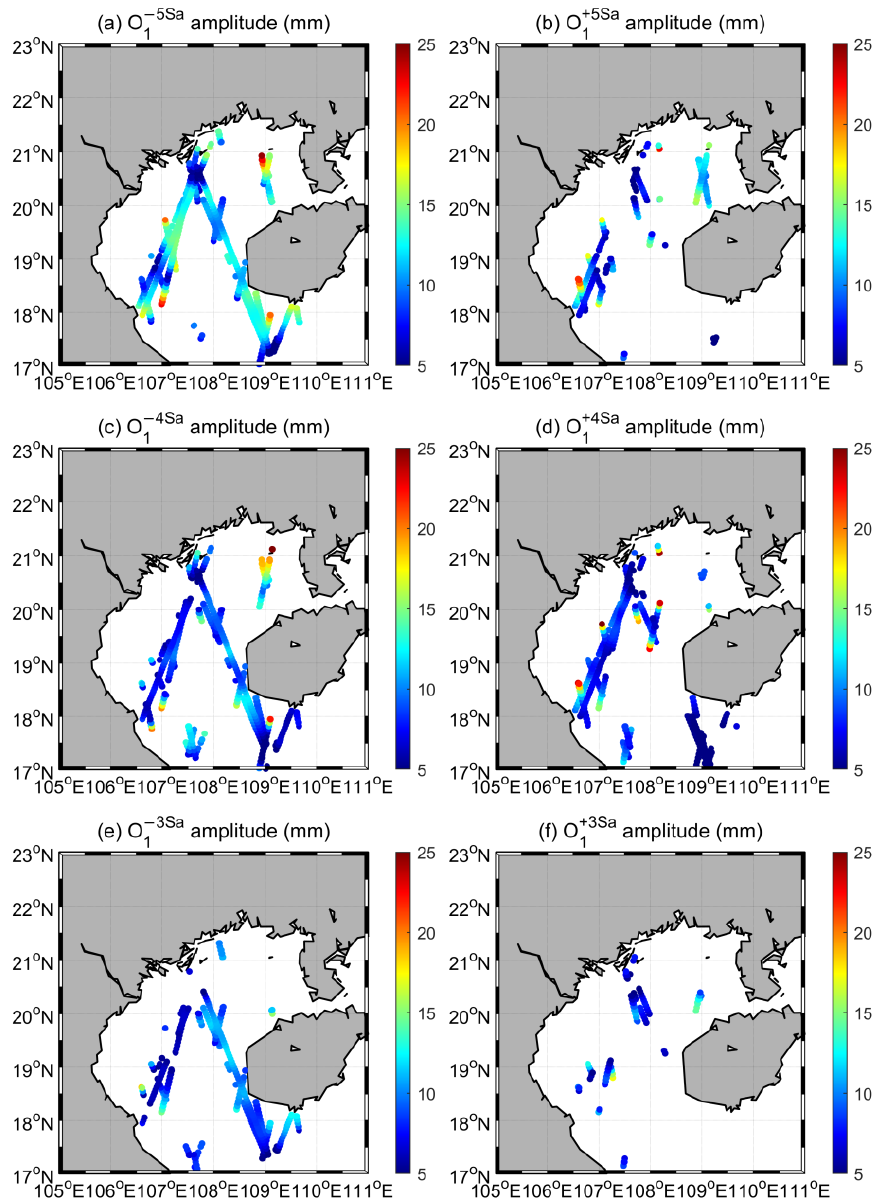
Figure 9. Estimated tidal amplitudes (unit: mm) in the Gulf of Tonkin from multi-satellite altimeter observations ( a ) O 1 − 5Sa ( b ) O 1+5Sa ( c ) O 1 − 4Sa ( d ) O 1+4Sa ( e ) O 1 − 3Sa ( f ) O 1+3Sa